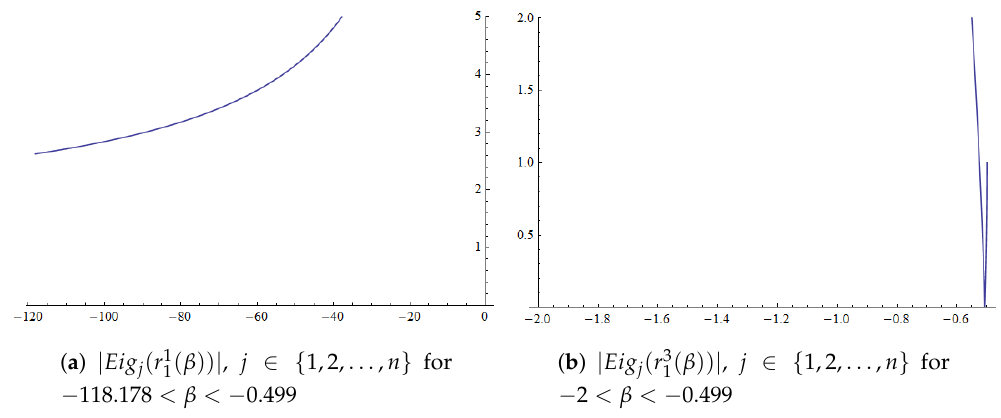
Figure 1. Stability of the fixed